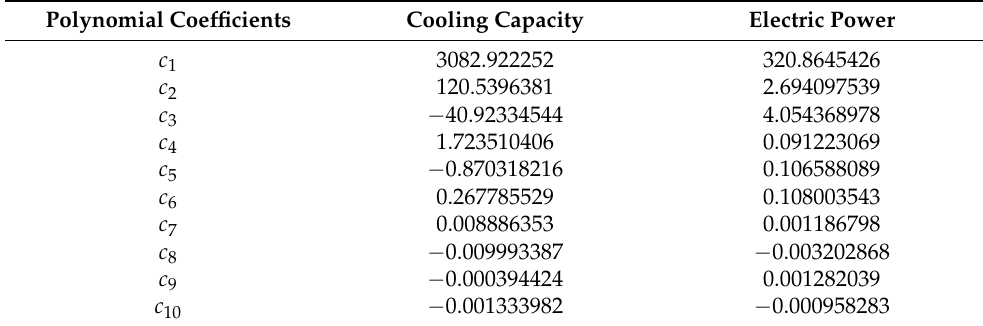
Table 1. The coefficients of polynomial (1) for capacity and the electric power of BITZER 2KES- 05Y